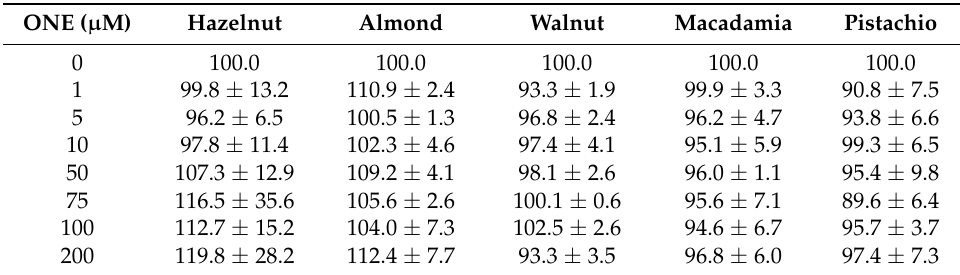
Table 2. Viable cell number (% of untreated control) of RAW264.7-macrophages after 24 h of incubation with 0–200 µ M oily nut extracts of different nut types. Values of untreated controls were set to 100% and data were expressed as means ± SD of three independent